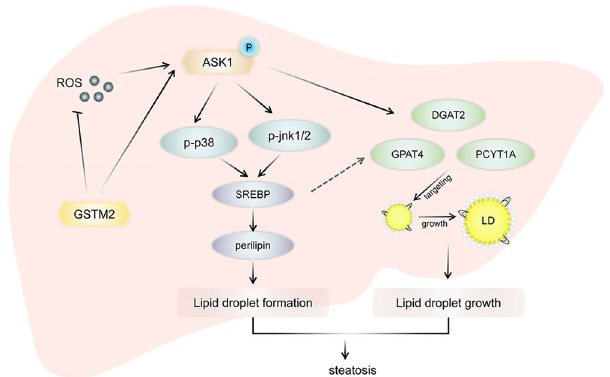
Fig. 7 GSTM2 protects against the development of hepatic steatosis